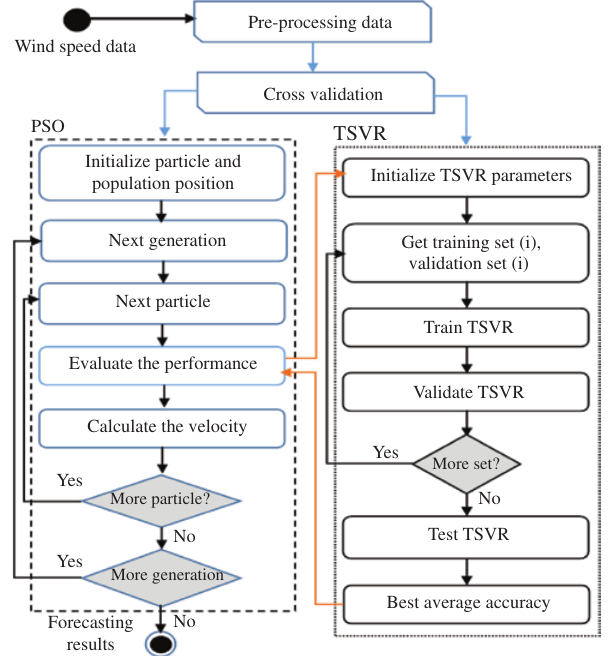
Figure 1: Framework of the Proposed PSO-TSVR Forecasting